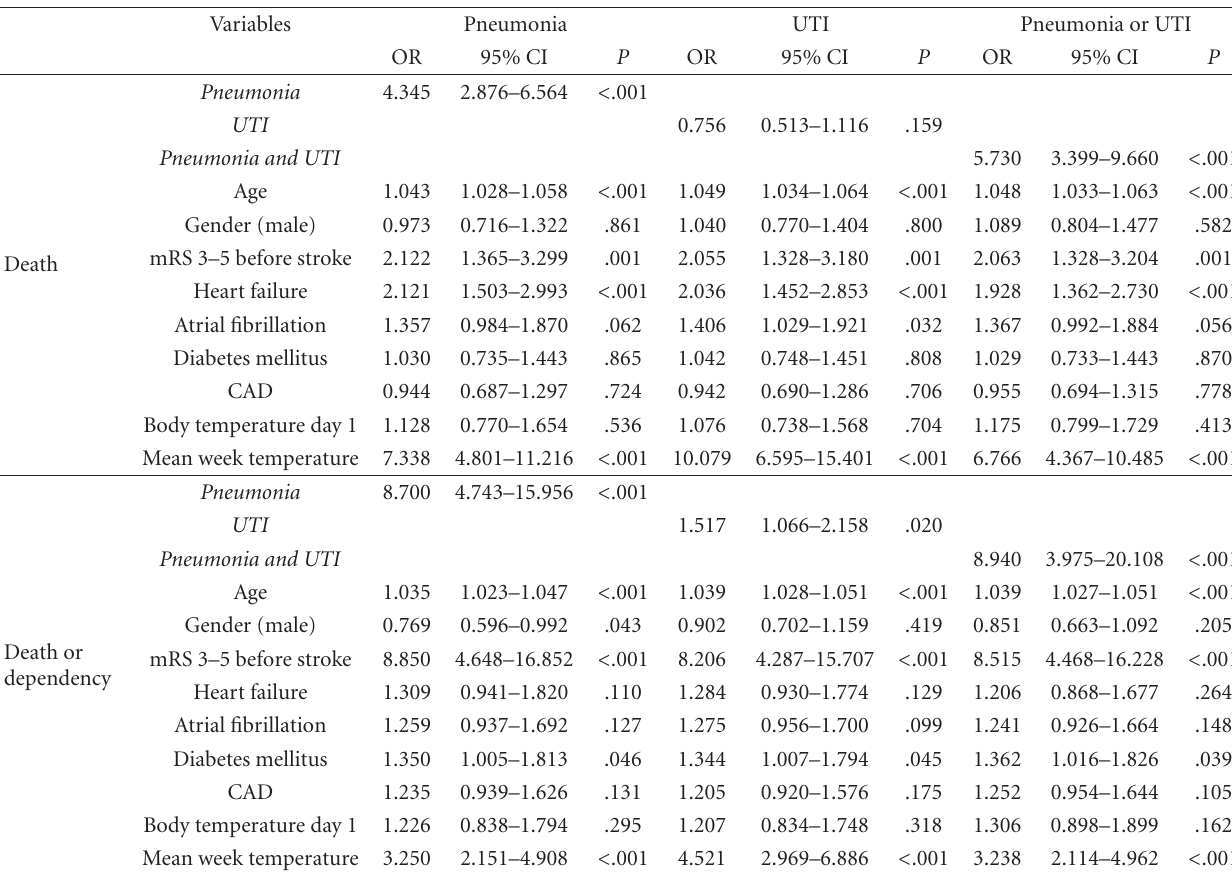
Table 5: Logistic regression for poor 90-day outcome (in-hospital